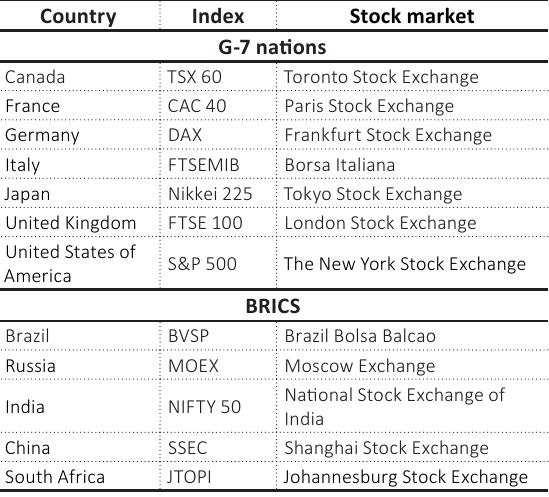
Table 1. List of countries, representative indices, and stock